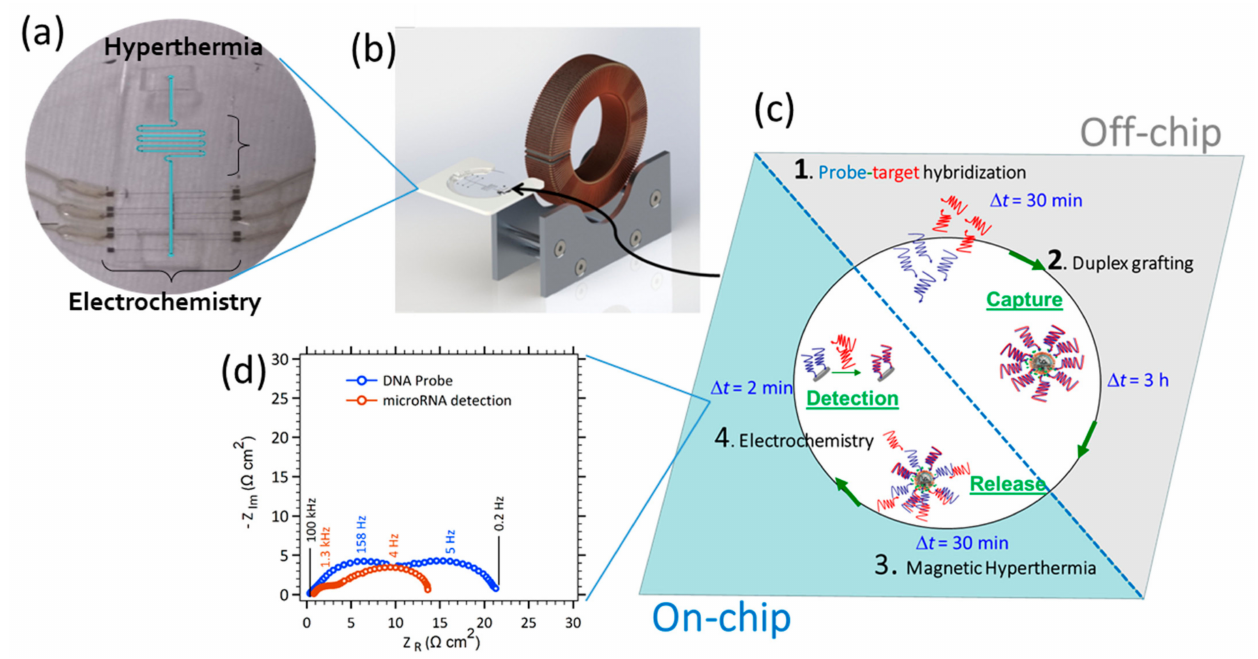
Figure 4. ( a ) Picture of the final PDMS/glass microfluidic setup for magnetic hyperthermia and electrochemical detection coupling. For convenient the microfluidic channel is highlighted in blue. ( b ) Microchip insertion for the localized magnetic hyperthermia through the ferrite gap. ( c ) On-chip hyperthermia protocol to release micro-RNA targets from magnetic nanoparticles coupled with electrochemical detection. (1) DNA probe and micro-RNA target are hybridized outside the chip. (2) Off-chip grafting of double-strand DNA/micro-RNA via peptide coupling on MNPs. (3) Introduction of functionalized MNPs in the microfluidic device for magnetic hyperthermia release under the AC magnetic field. Hybridization of released targets on the carbon microelectrode sensor functionalized with complementary probes. (4) micro-RNA electrochemical detection in 3 mM Fe III CN 63 − /Fe II CN 64 − , 10 − 8 M methylene blue (MB) diluted in 0.5 M NaCl electrolyte. ( d ) Electrochemical impedance responses of the electrochemical on-chip detection of hybridization (following hyperthermia on-chip step) between 100 kHz and 0.2 Hz with 10 mV AC signal perturbation on the microchannel electrode sensor filled with of 3 mM [Fe(III)(CN) 6 ] 3 − /[Fe(II)(CN) 6 ] 4 − + 10 − 8 M MB in 0.5 M NaCl. Nyquist plot of probe immobilized on carbon nitride microelectrode after circulating of 100 µ g mL − 1 DNA probe sequence diluted in 0.5 M NaCl for a 0.5 µ L s − 1 working